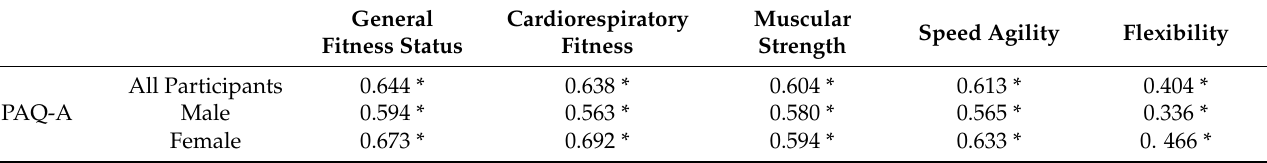
Table 3. Correlation between the level of physical activity and self-perceived level of physical fitness. General Cardiorespiratory Muscular Speed Agility Fitness Status Fitness Strength